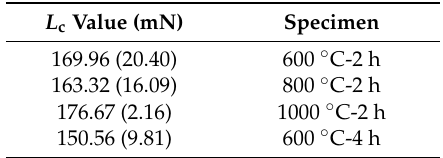
Table 4. L c values obtained by scratch test.